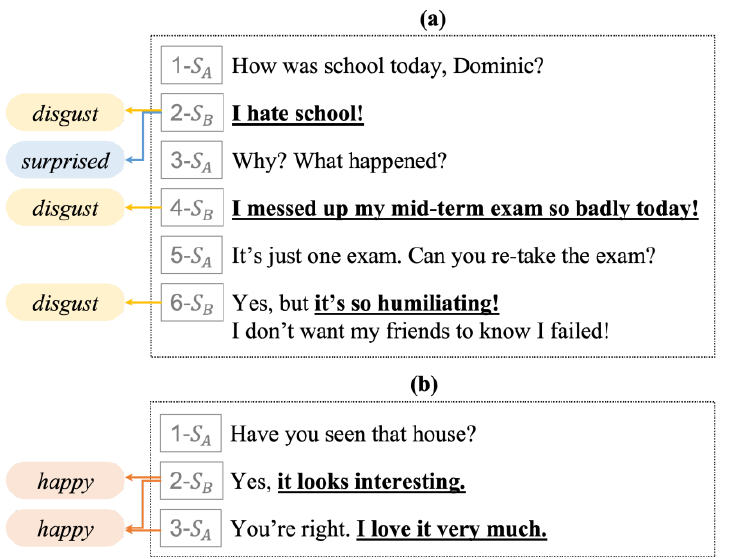
Figure 1. Examples of RECCON dataset; (a) example of the utterance having different emotions, and (b) example of two or mor causes representing a single emotion.